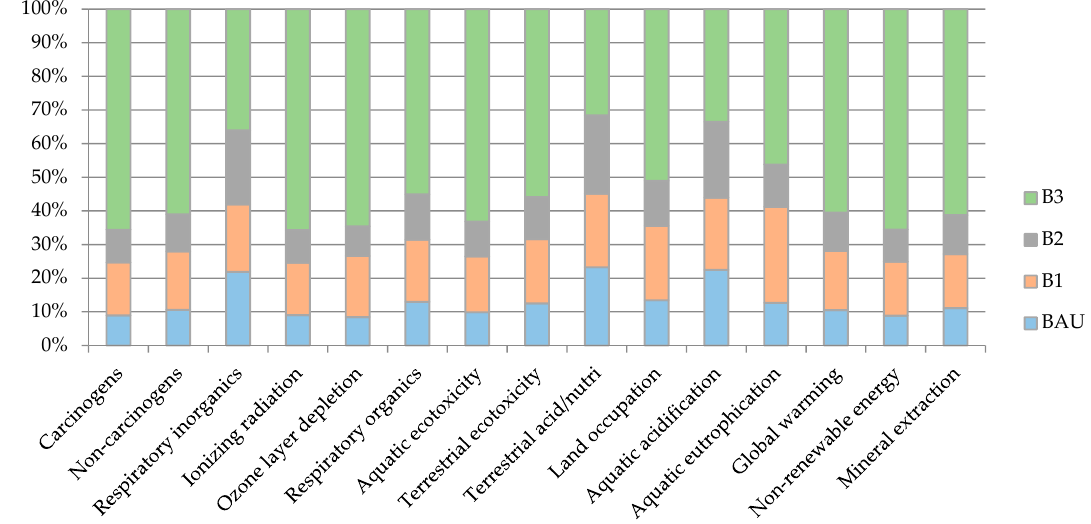
Figure 6. Sensitivity analysis for Biogas Plant B—changes in the type of feedstock.